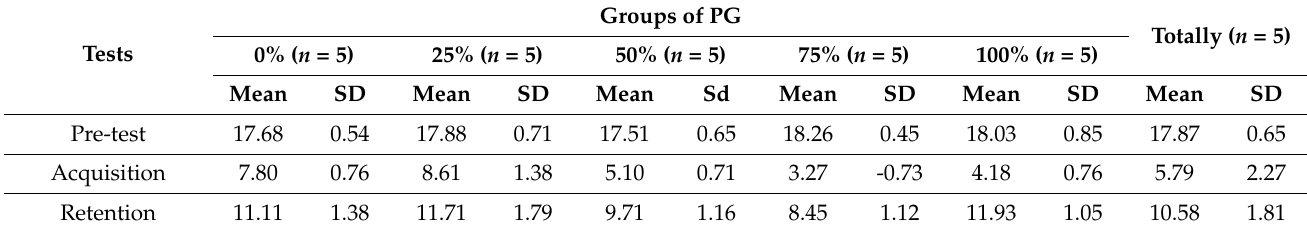
Table 2. Descriptive to the error values obtained in three consecutive